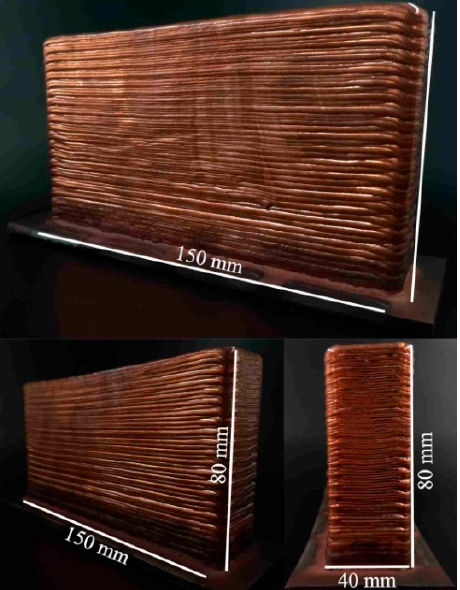
Figure 6. The macrostructure of C-type blocks fabricated using scanning strategy 3 with electron beam wire-feed additive technology.